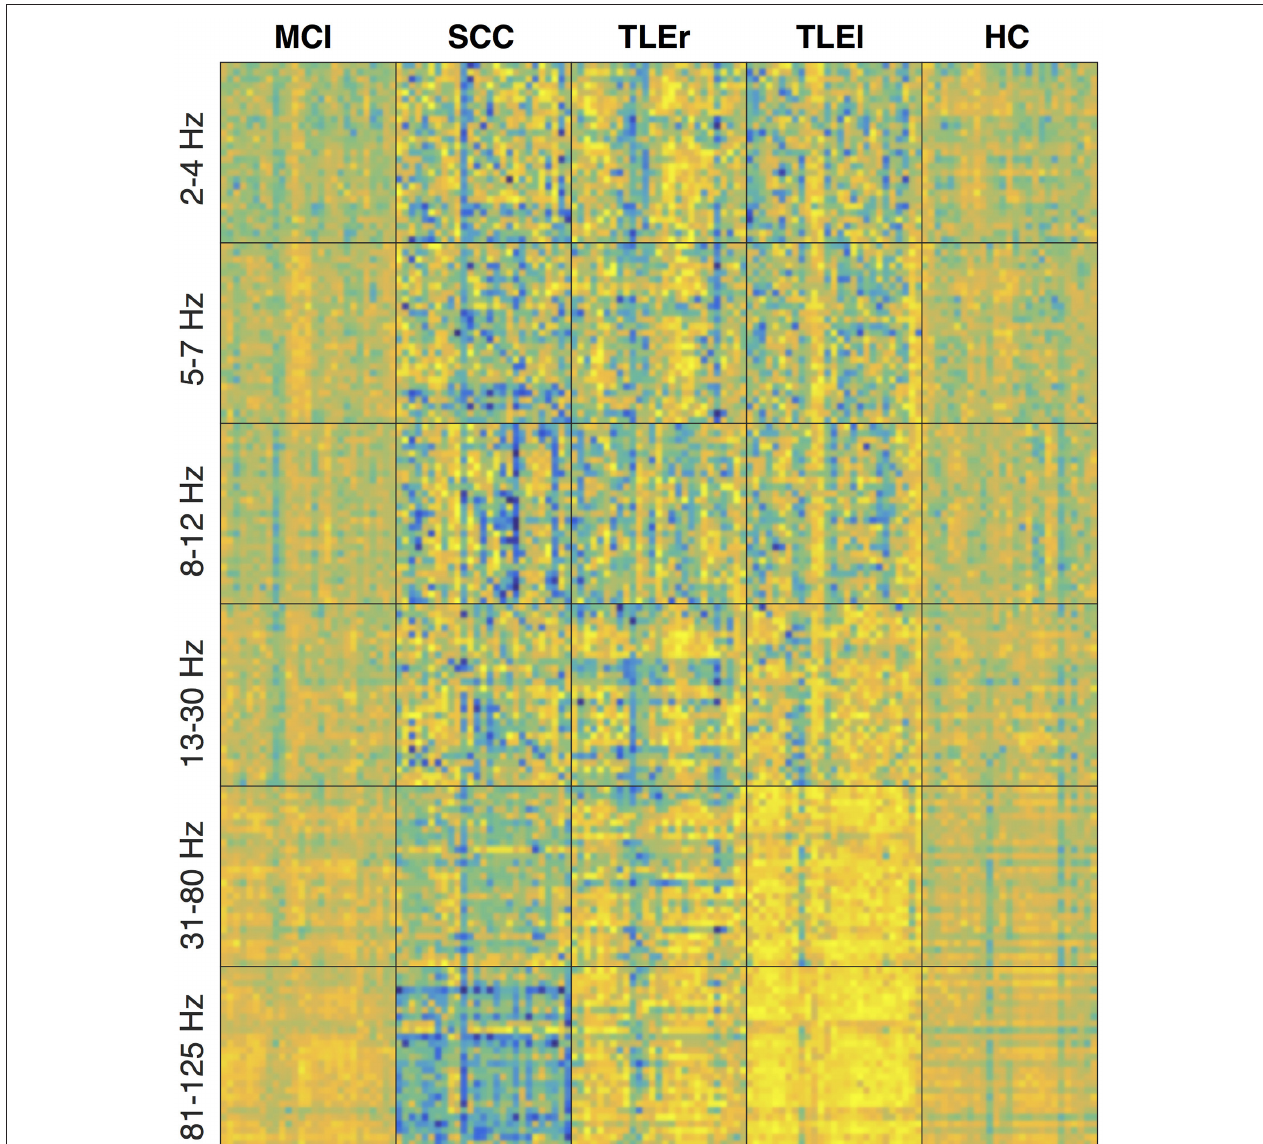
FIGURE 6 | Heatmaps of the reliability of all electrode × electrode interactions for full frequency directed transfer function, sorted by frequency in rows and groups in columns. Colors indicate values from − 1 (dark blue) to + 1 (bright yellow). Electrodes start from top left following the order F3, F4, C3, C4, P3, P4, O1, O2, F7, F8, T7, T8, P7, P8, Fz, Cz, Pz, FC1, FC2, CP1, CP2, FC5, FC6, CP5, CP6, TP9, and TP10. MCI, mild cognitive impairment; SCC, subjective cognitive complaints; TLEr, right lateralized temporal lobe epilepsy; TLEl, left lateralized temporal lobe epilepsy; HC, healthy